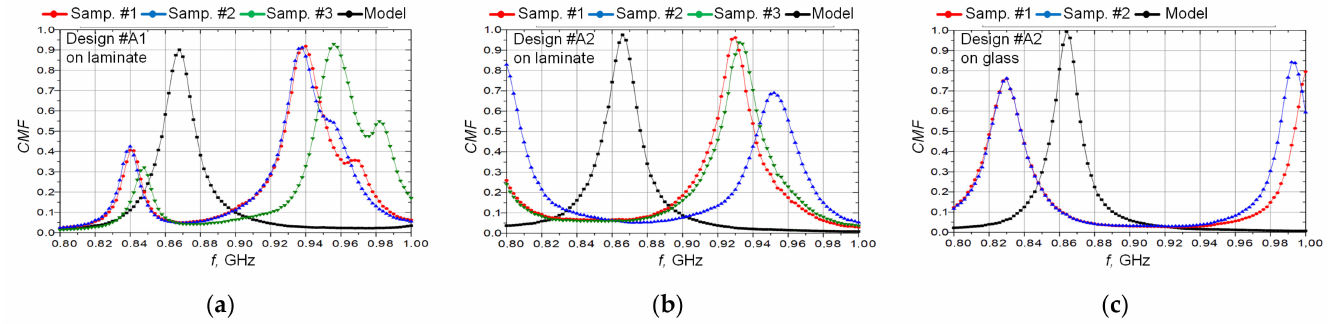
Figure 7. CMF of RFID antenna: ( a ) Design #A1 on low-iron laminate; ( b ) Design #A2 on low-iron laminate; ( c ) Design #A2 on low-iron glass.